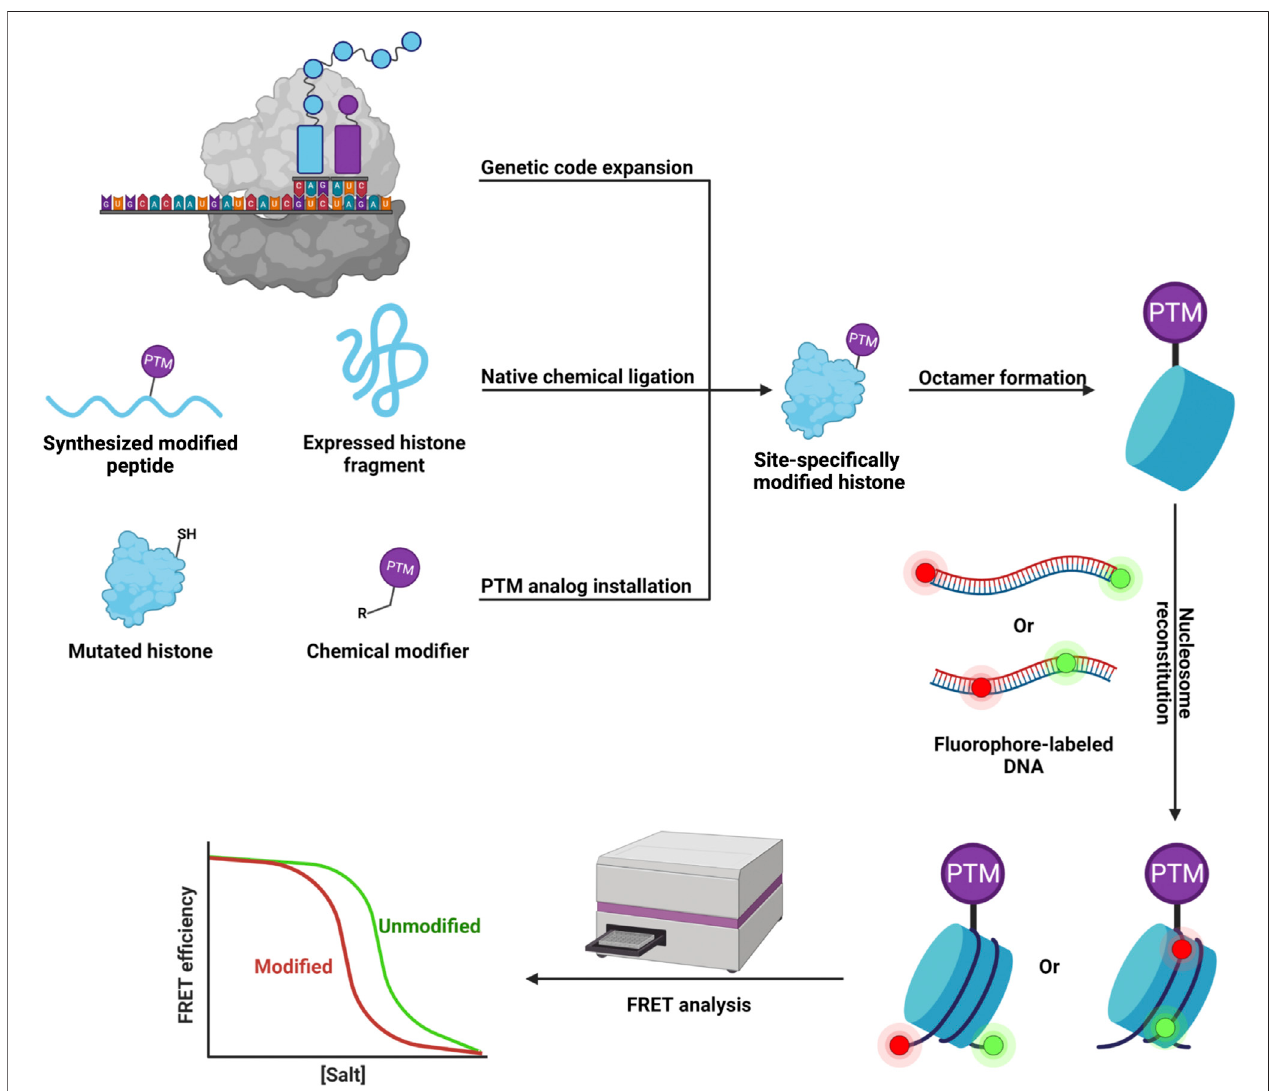
FIGURE 2 | Work fl ow of the in vitro FRET-based assay for studying the effects of site-speci fi c histone PTM on nucleosome dynamics.